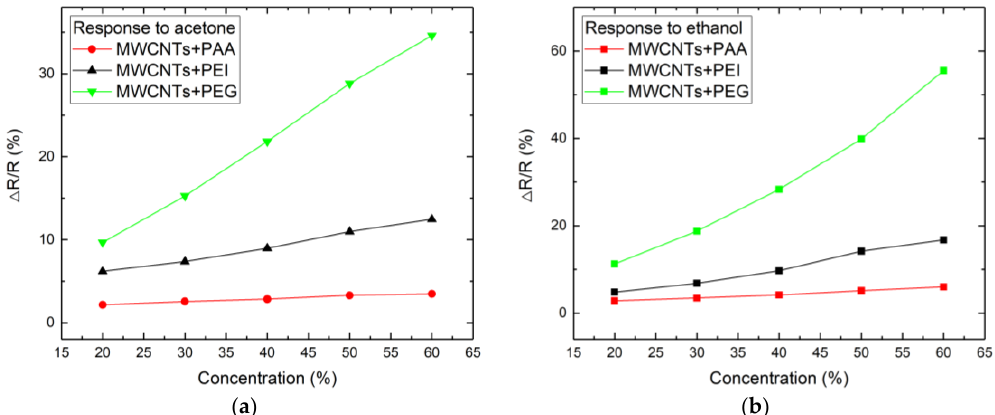
Figure 7. Sensor responses for various sensitive layer and vapors. The vapors corresponding to the figures are ( a ) acetone; ( b ) ethanol.